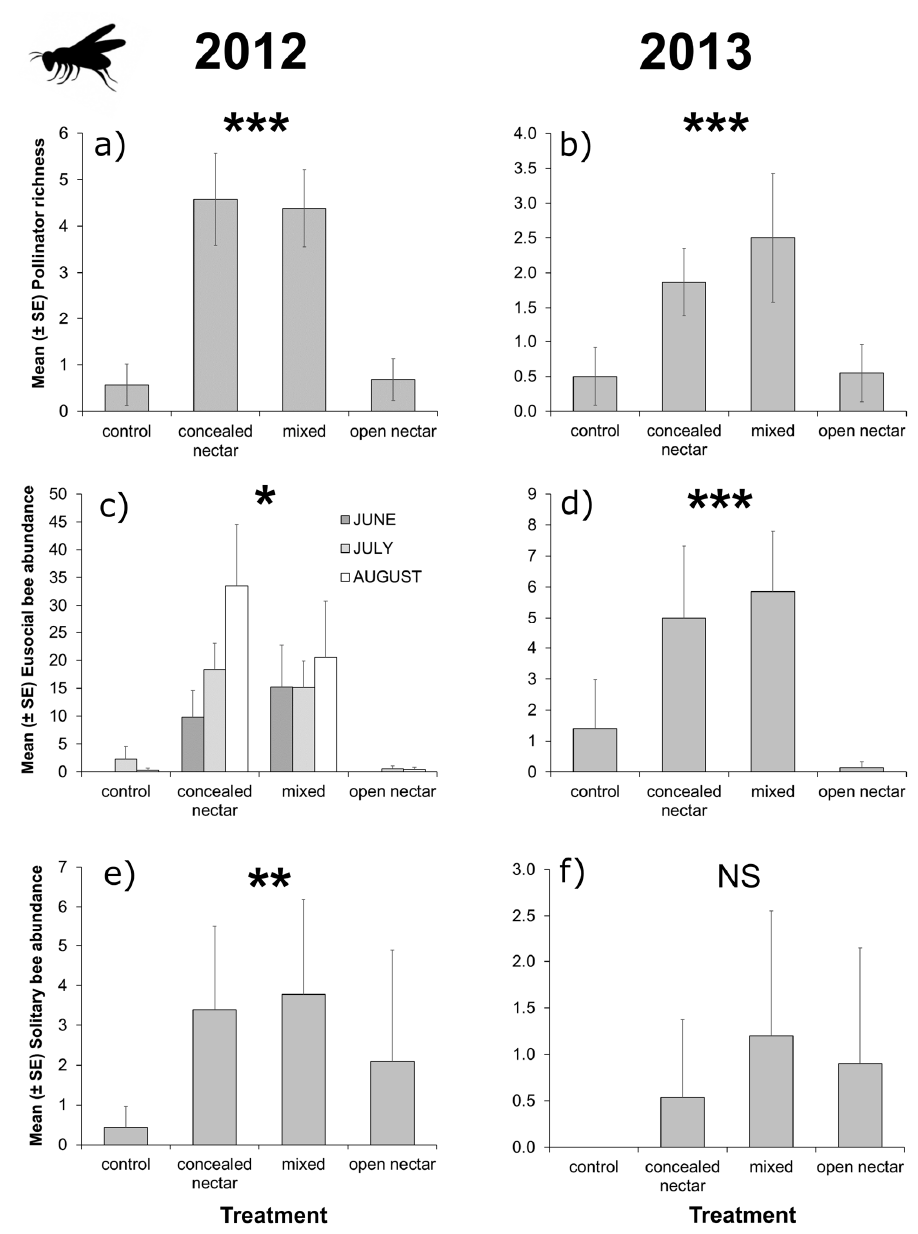
Figure 1. Effects of flower strips on flower-visiting pollinators in orchard alleyways. We detected significant effects of treatment (control, concealed-nectar, mixed, and open-nectar) on pollinator richness in either study year ( a , b ); an effect of the interaction between treatment and sampling month (June, July, and August) on eusocial bee abundance in 2012 ( c ); an effect of treatment on eusocial bee abundance in 2013 ( d ); and an effect of treatment on solitary bees in 2012 ( e ); but not 2013 ( f ). Error bars show standard errors and asterisks show level of significance (NS = p > 0.05, * = p < 0.05, ** = p < 0.01, *** = p < 0.001) reported in LRTs (see Table 1 and main text for details).